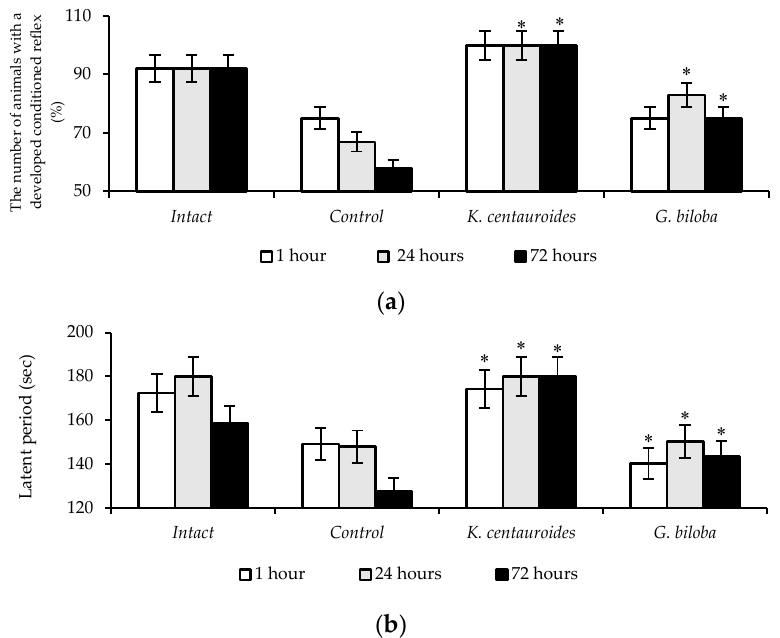
Figure 2. The number of animals with developed passive avoidance reflex ( a ) and the duration of the latent period ( b ) during prolonged scopolamine exposure in rats; intact (saline + dist. water), control (scopolamine + dist. water), K. centauroides (scopolamine + K. centauroides , 100 mg/kg), G. biloba (scopolamine + G. biloba , 100 mg/kg). The conventions are similar for Figure 3 and Tables 3–5. *— p < 0.05 vs. control group. Table 3. Morphometric parameters of the rats’ cerebral cortex and hippocampus with prolonged scopolamine